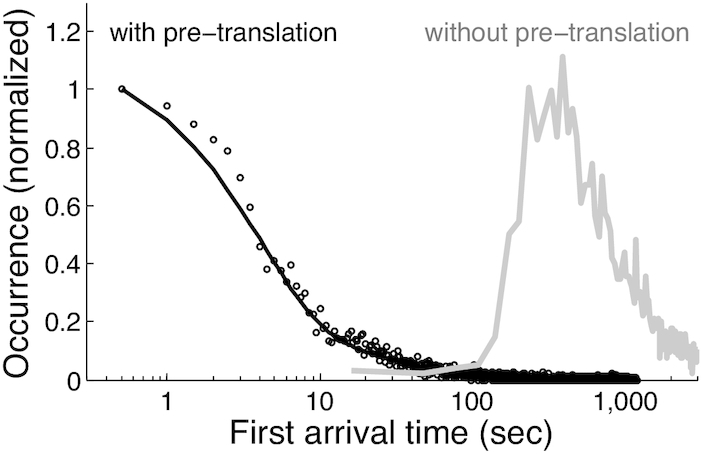
Histograms of first arrival time for Cy3-antiFLAG binding with (black) and without (gray) pre-translation. Black: YE translation of 3′-end tethered 3xFLAG-Fluc mRNA was used to generate ribosome/nascent peptide/mRNA complexes on the detection surface. YE/Cy3-antiFLAG was then flowed into the channel and antiFLAG binding to pre-existing nascent 3xFLAG peptides was measured. n = 4516 trajectories. The first arrival time histogram (black circles) fits reasonably well to a double exponential distribution (black curve): \documentclass[12pt]{minimal}
\usepackage{amsmath}
\usepackage{wasysym}
\usepackage{amsfonts}
\usepackage{amssymb}
\usepackage{amsbsy}
\usepackage{upgreek}
\usepackage{mathrsfs}
\setlength{\oddsidemargin}{-69pt}
\begin{document}
}{}$y = {A_1}/{\tau _1} \cdot {e^{ - t/{\tau _1}}} + {A_2}/{\tau _2} \cdot {e^{ - t/{\tau _2}}}$\end{document}, with τ1 = 3.9 ± 0.2 (s.e.) s, τ2 = 38 ± 2 (s.e.) s, and A1/A2= 13 ± 1(s.e.). A boot-strapping method was used for fittings, as described previously (54). Gray: YE/Cy3-antiFLAG was delivered into the flow channel immediately after mRNA surface immobilization and antibody binding was measured during real-time translation. n = 2728 trajectories. The x-axis is in log scale for better visualization because antibody binding under these two conditions occur on very different time scales. The same data and fit result for the condition with pre-translation are shown again in linear scale in Supplementary Figure S4A.